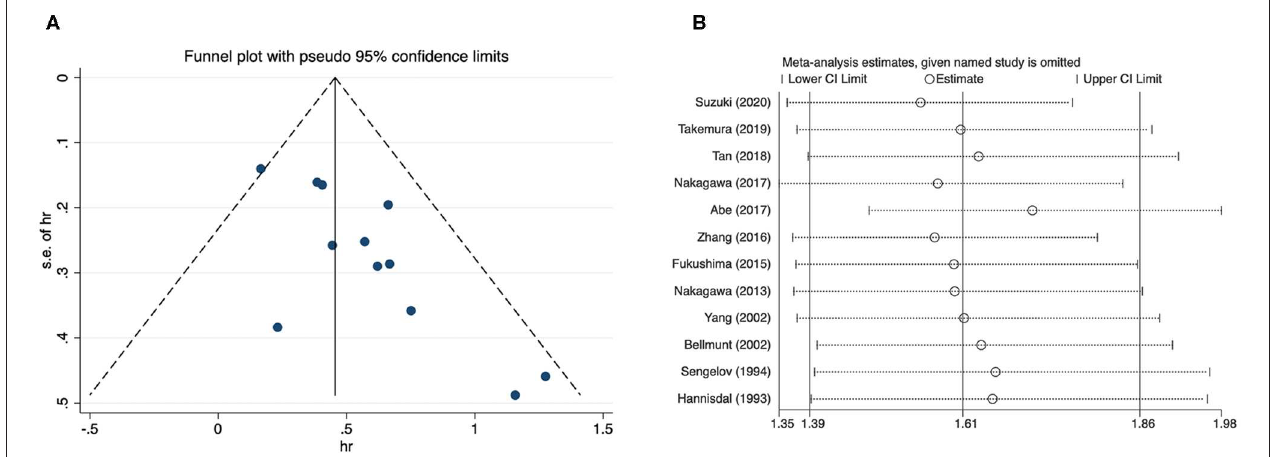
FIGURE 4 | Funnel plot and sensitivity analysis for overall survival of urothelial carcinoma. (A) Funnel plot; (B) sensitivity